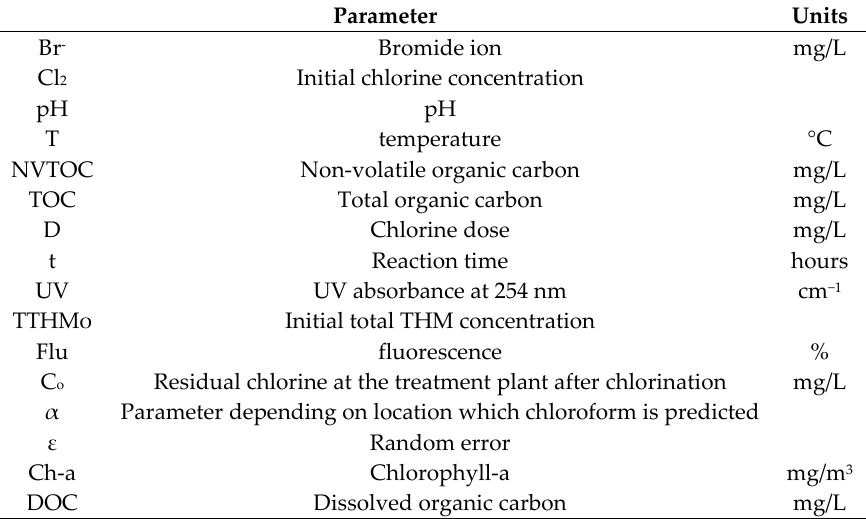
Table 2. DBPs predictive models’ parameters (based on